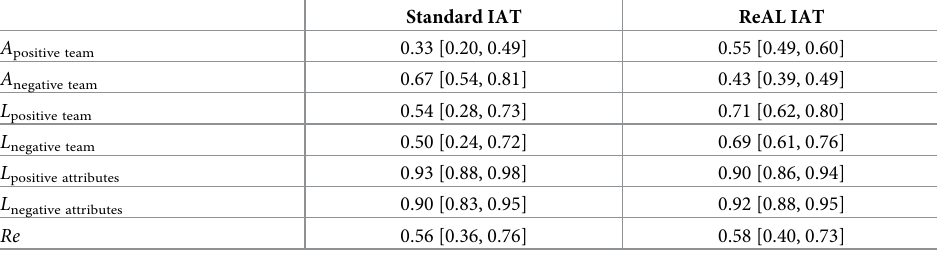
Table 3. Parameter estimates from Replication Experiment